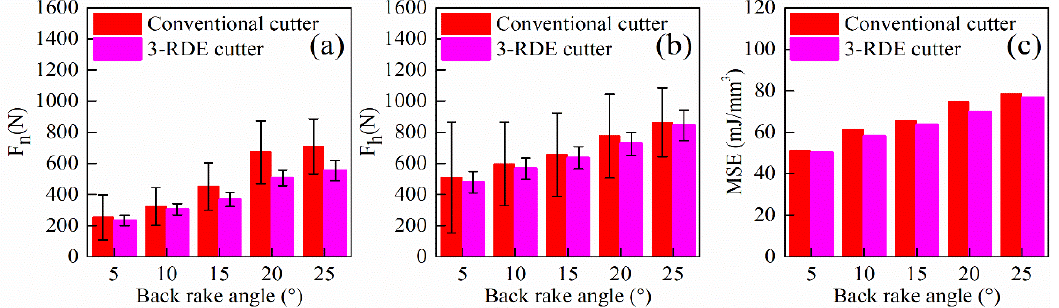
Figure 7. Comparison of cutting forces and MSE between conventional cutter and 3-RDE cutter: ( a ) F n ; ( b ) F h ; ( c ) MSE.